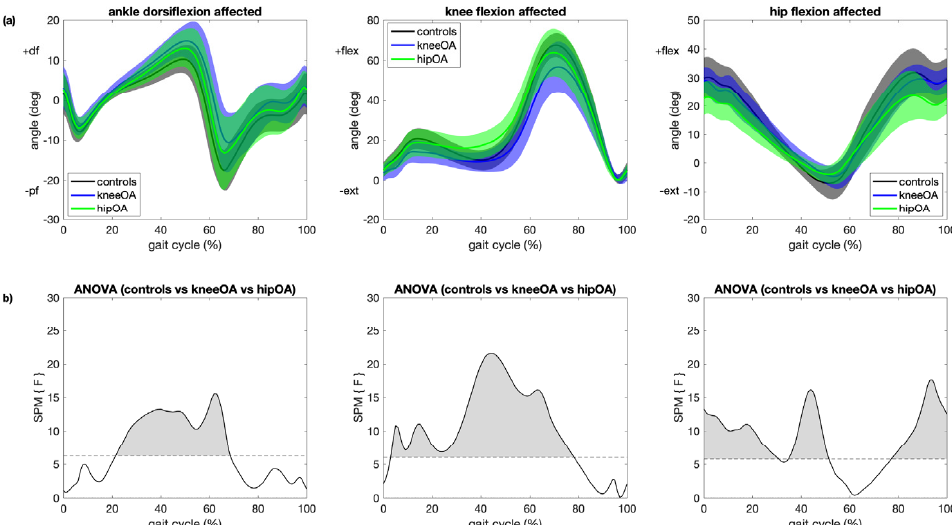
Figure 1. Comparison between all participant groups. ( a ) Mean and 1 standard deviation joint angle trajectories for ankle dorsiflexion (left), knee flexion (center) and hip flexion (right) angle for the 图一 affected/left leg for patients with knee OA (blue), patients with hip OA (green) and controls (black); ( b ) results of statistical parametric mapping with analysis of variance (SPM{F}) where regions with statistically significant difference between all groups are indicated as grey regions ( p <